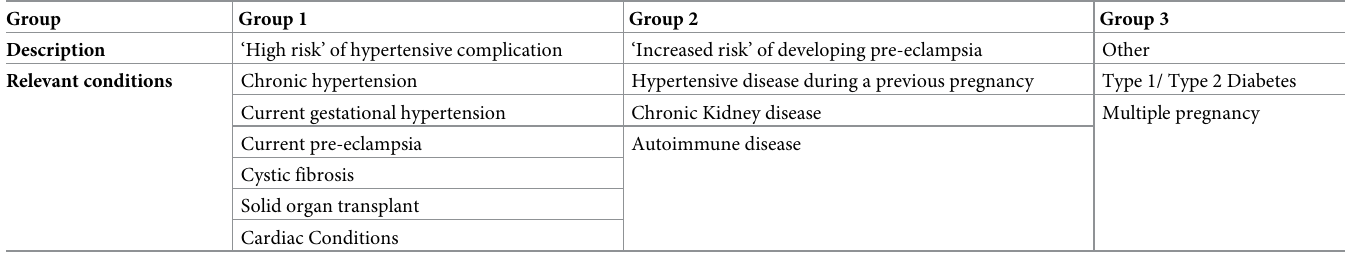
Table 1. Programme eligibility criteria for women by